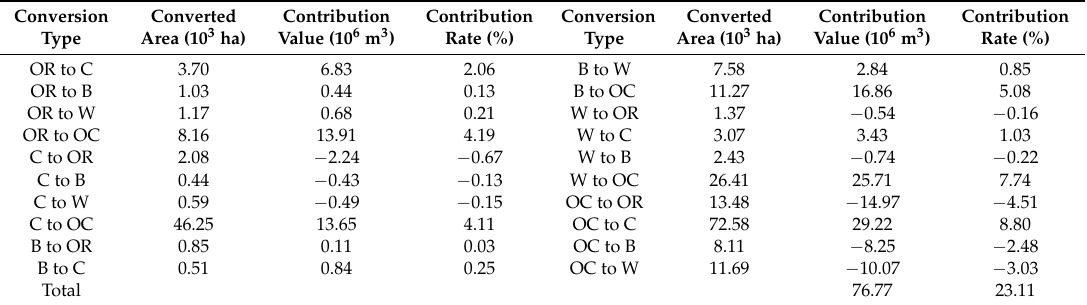
Table 4. Crop conversion contributions to IWR c changes within the HRB between 2007 and 2012. Conversion Converted Contribution Contribution Conversion Type Area (10 3 ha) Value (10 6 m 3 ) Rate (%)